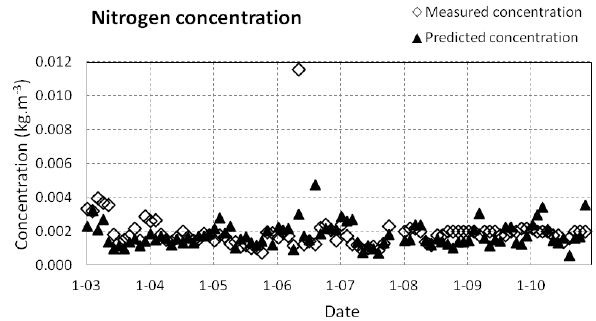
Fig. 4. Comparison of measured and predicted nitrogen concentra- tions in river. Figure 4. Comparison of measured and predicted nitrogen concentrations in river. 2